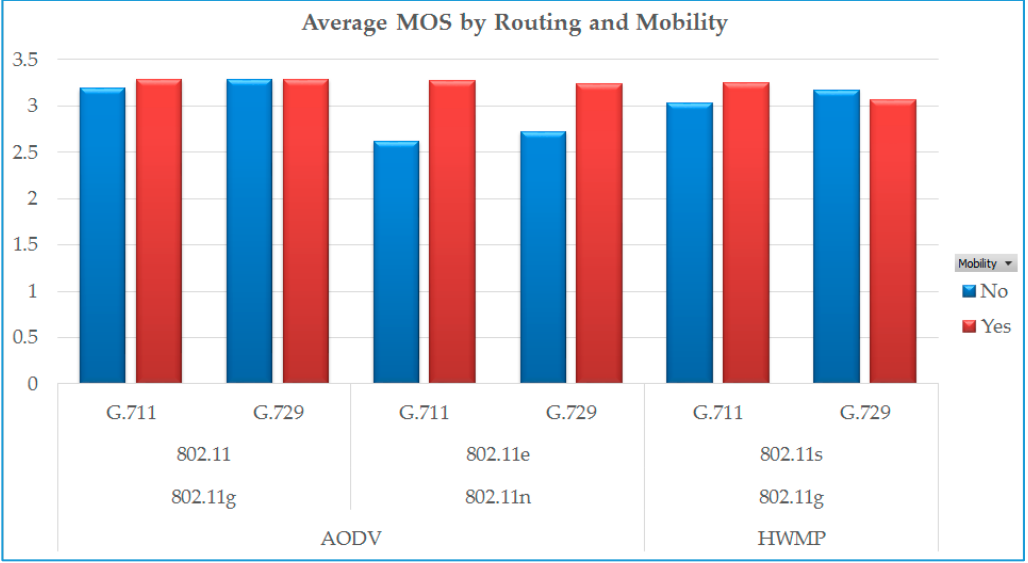
Figure 21. Average MOS by routing and mobility.